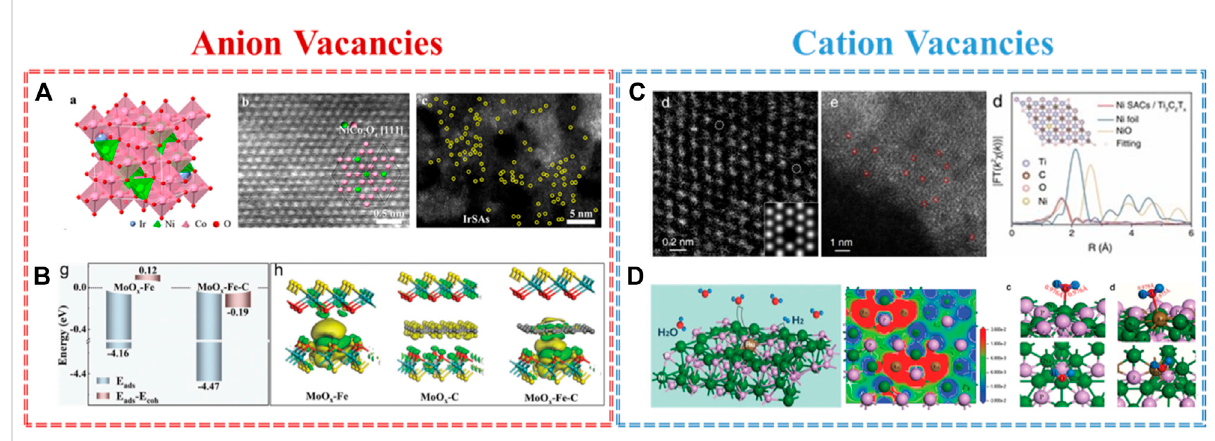
FIGURE 2 Anionvacancies: (A) IrSACssupportedonOvacancyinNiCo 2 O 4 forOER(Yinetal.,2020)and (B) FeSACssupportedonSvacancyinMoS 2 -Cfor HERandOER(Gongetal.,2022).Cationvacancies: (C) NiSACssupportedonTivacancyinMXeneforhydrazineoxidationreaction(Zhouetal.,2022) and (D) Ru SACs supported on Ni vacancy in Ni 5 P 4 for HER (He et al.,